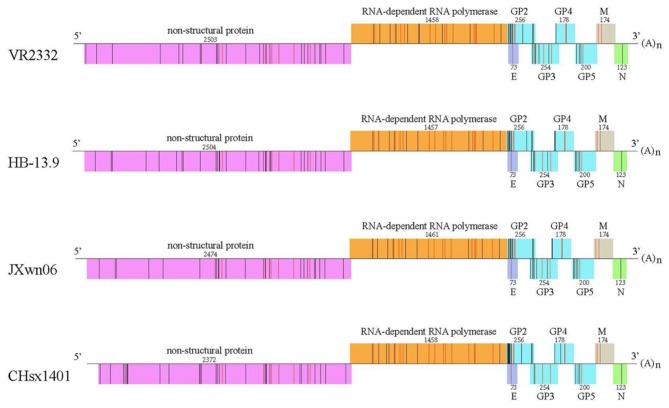
Peptide predictions from different PRRSV strains according to the binding motifs of the pSLA-1*1502 complex. Genome-wide scanning results for peptides matching the following motifs of the pSLA-1*1502 complex: X-(S/M/F/W/T/V/I/L)-(L/P/M/F/S/N)-X-X-X-X-X-(F/Y/W). Different proteins are indicated by different colors. The number above indicates the sequence length of each protein. The non-apeptides matching the motifs of the pSLA-1*1502 complex from different proteins are indicated by bars, and red indicates the conserved peptides in four PRRSV strains, including the first isolated strain VR2332 (GenBank accession # EF536003.1); the low-virulence strain HB-13.9 (GenBank accession # EU360130.1); the highly pathogenic strain JXwn06 (GenBank accession # EF641008.1); and the CHsx1401 strain, which was responsible for a recent epidemic in China (GenBank accession # KP861625.1).